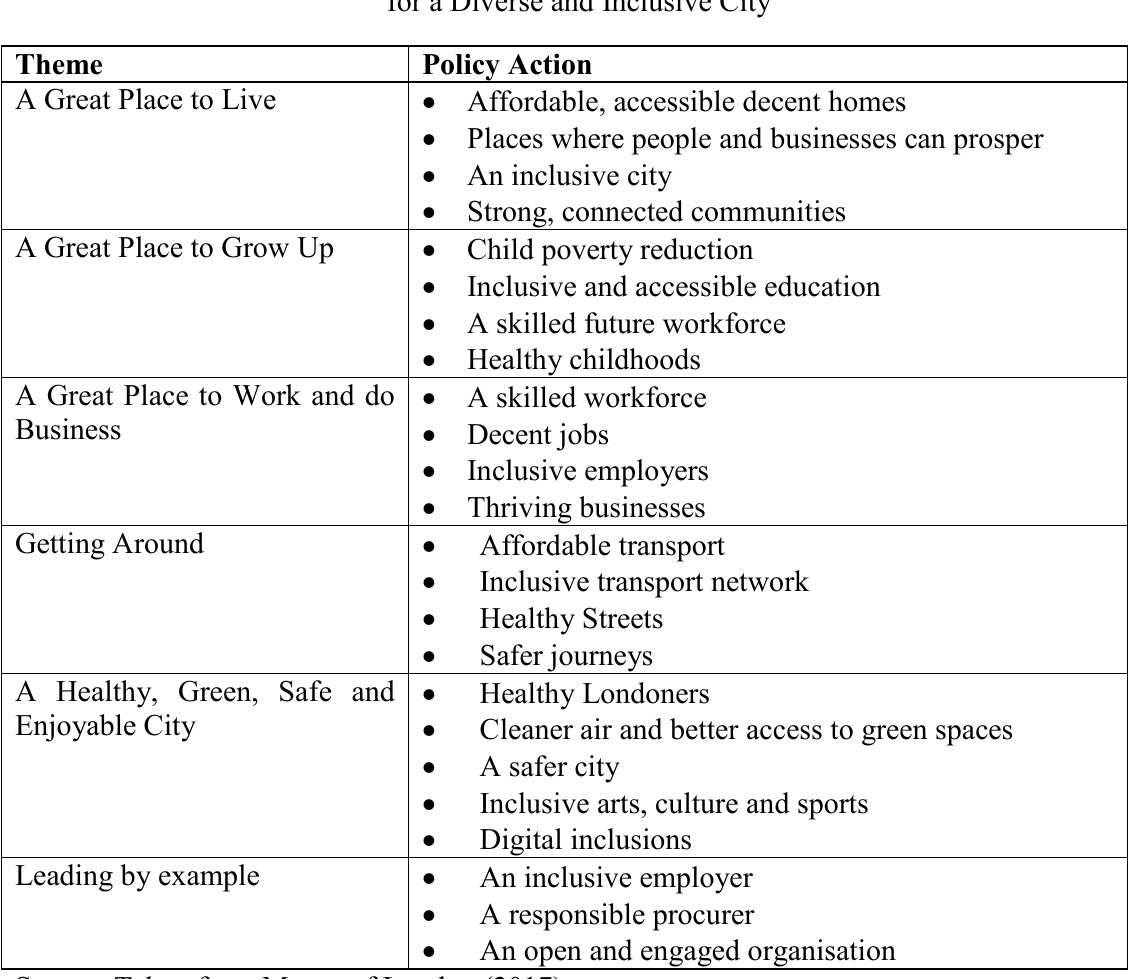
Figure 2: Themes and Policy Actions in Mayor of London’s